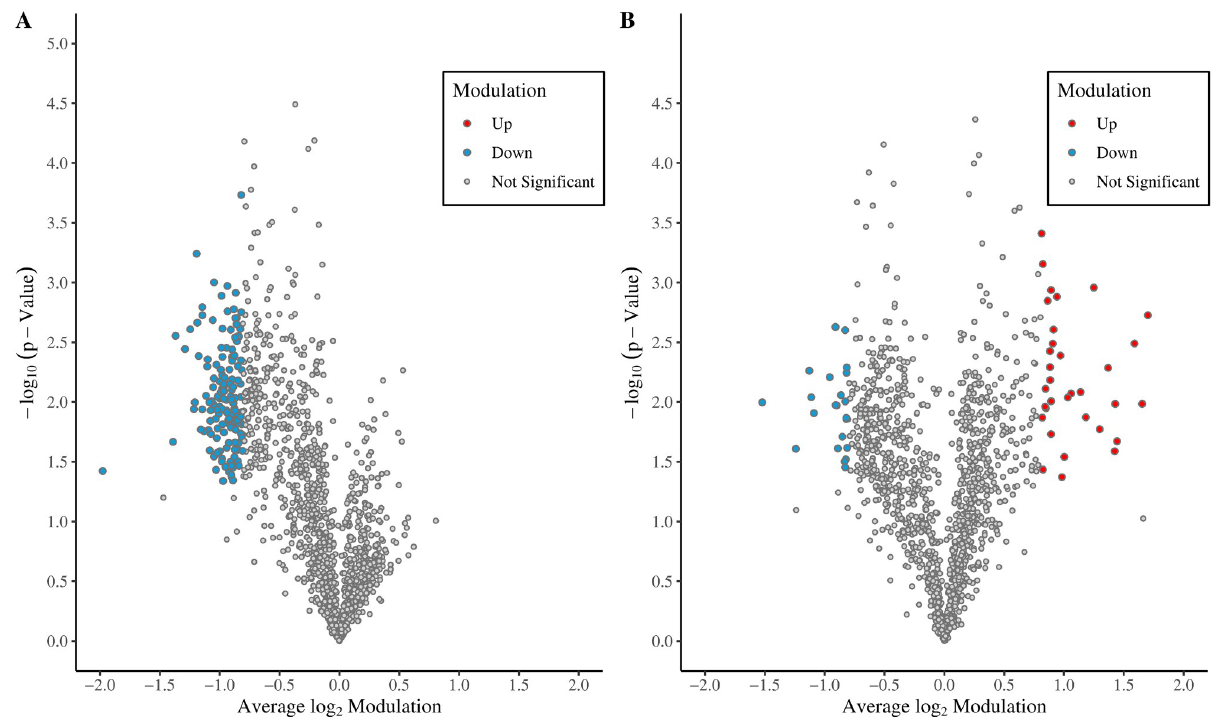
Fig 4. Volcano plot obtained from 3-plex SILAC-based quantitative analysis of autophagosome-associated proteins. The average of three log 2 transformed Leishmania -infected/ rapamycin-treated (A) or Leishmania -infected/starvation SILAC protein ratios (B). Red and blue dots represent proteins exhibiting significant fold changes (at least 75%) up and down respectively, p < 0.05, n = 3.